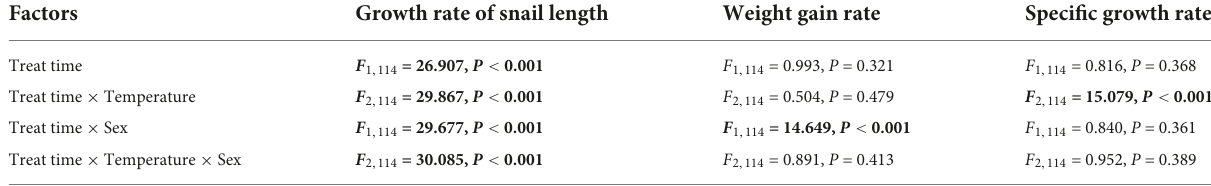
TABLE 2 Results of two-way repeated measures ANOVA to test the effect of temperature and sex as fixed factors, with treated time as within-subject factor, during different period on growth rate of morphological index. Factors Growth rate of snail length Weight gain rate Specific growth